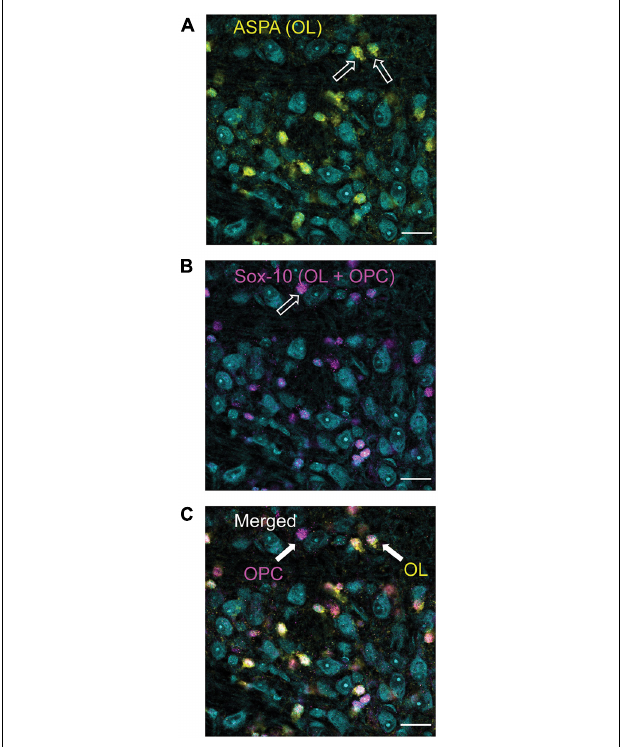
FIGURE 1 | Differentiation of oligodendrocyte (OLs, ASPA) and oligodendrocyte precursor cells (OPCs, Sox-10 no ASPA). ASPA, a stain specific for mature OLs is shown in yellow [panel (A) ]. These yellow cells were used to calculate the number of mature OLs in each image. Sox-10 is a marker specific for the entire OL lineage (OPCs and OLs) and is labeled in magenta (B) . To determine the number of OPCs in each image, cells that were labeled with Sox-10 but not ASPA (as indicated by the arrow labeled OPC) were counted (C) . MNTB cell bodies are indicated in cyan with a Nissl stain.